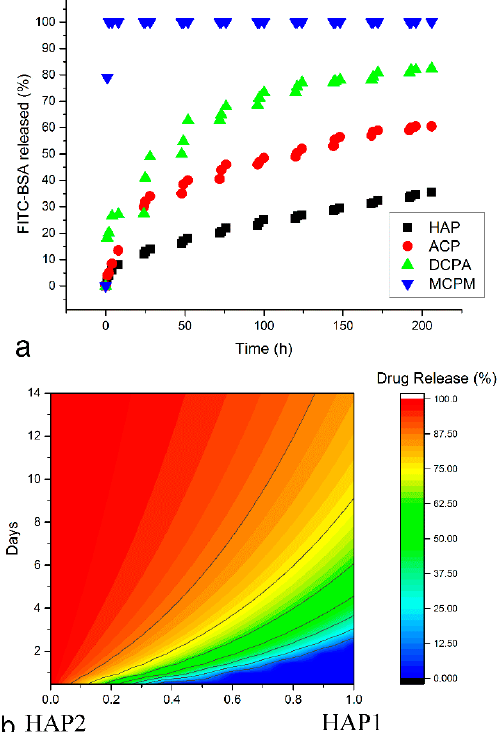
Figure 3. ( a ) Release of serum albumin (FITC-BSA) over time from different monophasic CAP nanopowders: hydroxyapatite (HAP), amorphous CAP (ACP), dicalcium phosphate anhydrous (DCPA), and monocalcium phosphate monohydrate (MCPM); ( b ) Release of vancomycin from